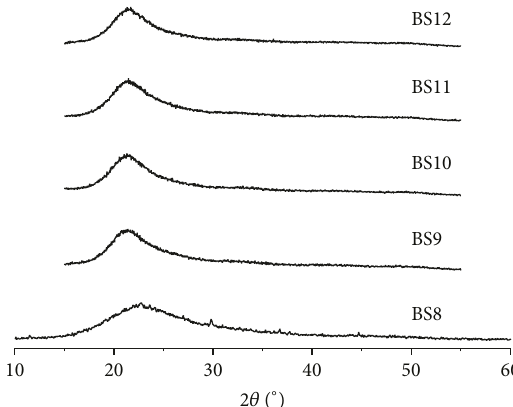
Figure 5: XRD patterns of the synthesis products obtained by hydrothermal treatment of sugarcane waste ash at 90 ∘